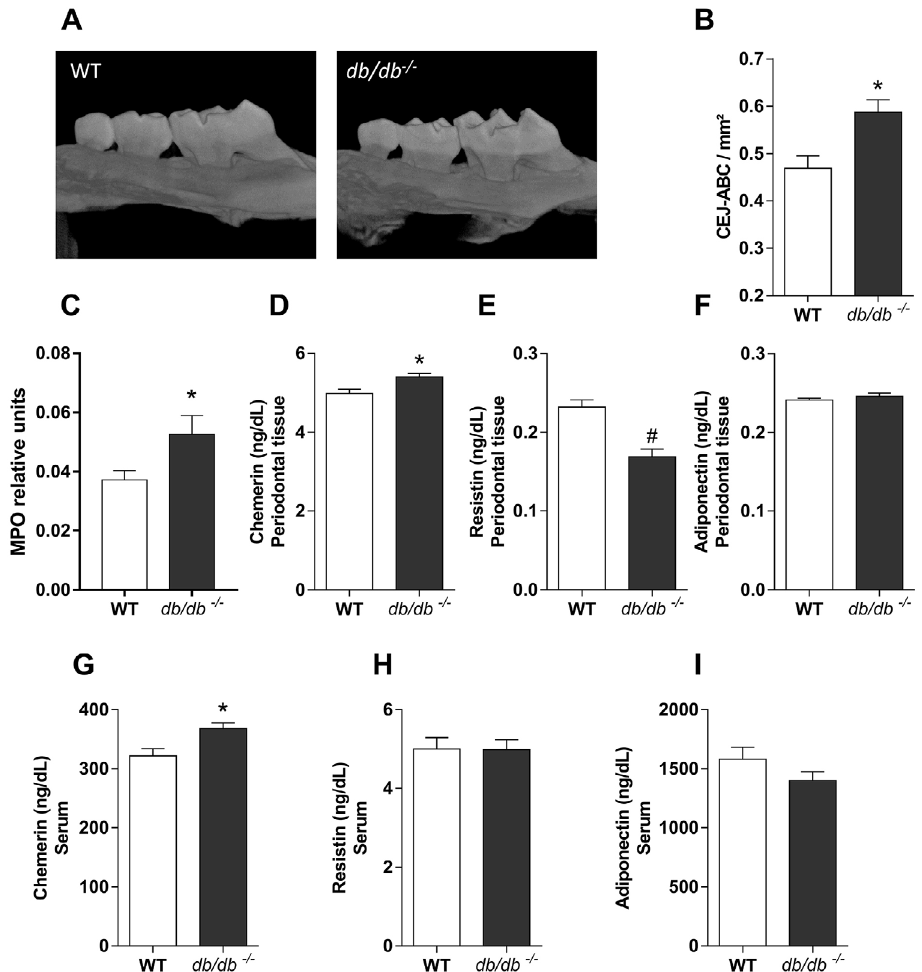
Figure 2- Analysis of periodontal tissues and serum changes in db/db-/- mice. (A) Representative images of alveolar bone loss in WT and db/db-/- mice. (B) Analysis of alveolar bone loss in WT and db/db-/- mice. (C) MPO quantification in periodontal tissues of WT and db/db-/- mice. (D) Chemerin concentration in periodontal tissues. (E) Resistin concentration in periodontal tissues; (F) Adiponectin concentration in periodontal tissues; (G) Chemerin serum levels. (H) Resistin serum concentration. (I) Adiponectin serum concentration. N=10, *, #p<0.05 as per Student’s t-test. The values (mean ± S.E.M) of all experiments were obtained from two independent experiments, with 40